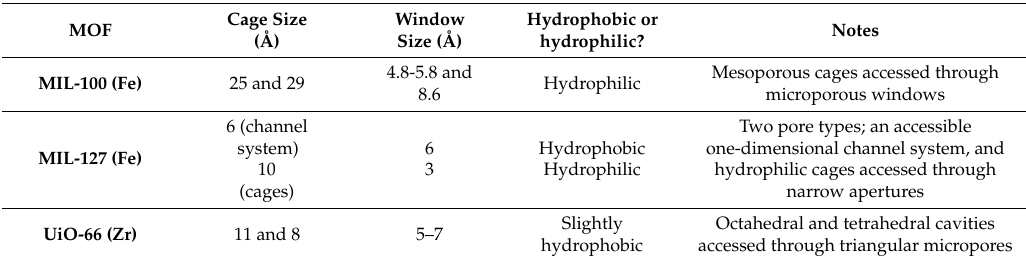
Table 1. Properties of the MOFs used in the